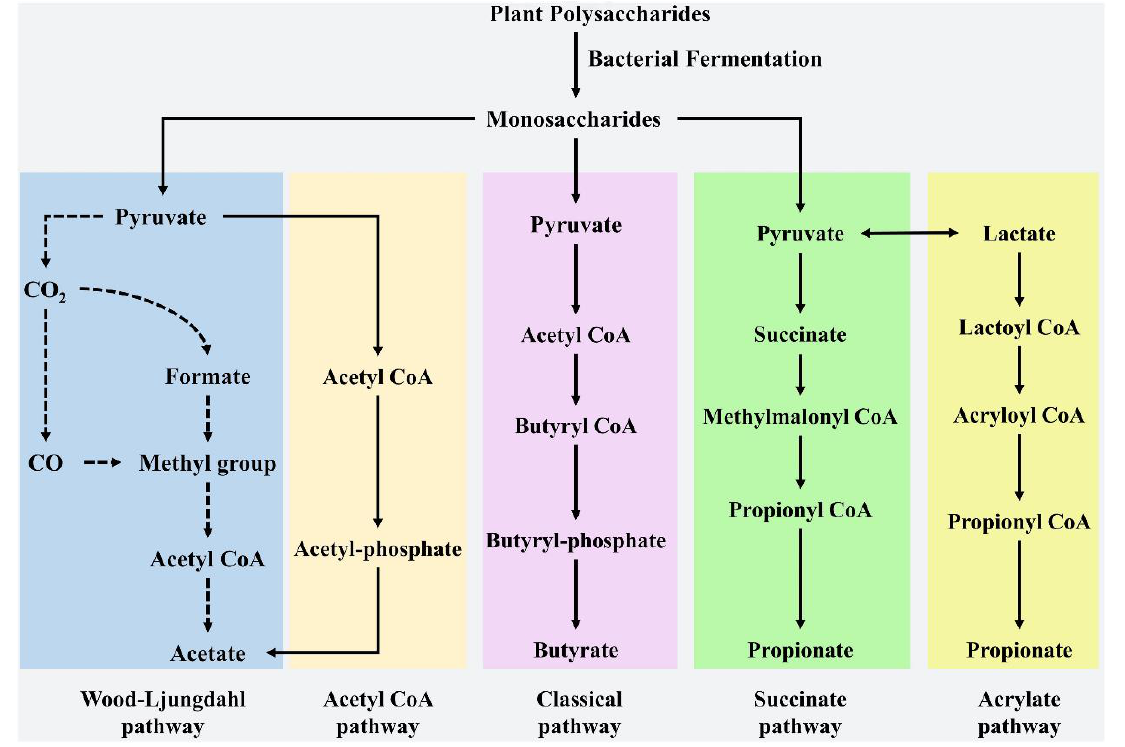
Figure 1. Synthesis pathway of SCFAs [55] Reprinted with permission from Ref. [55], Liu et al. (2021)